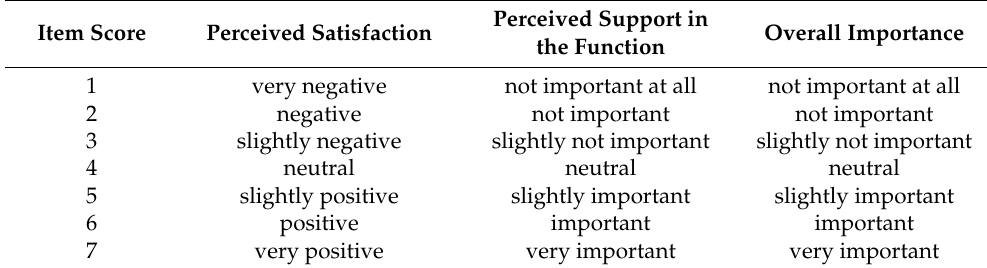
Table 6. Scoring table for the post-test questionnaire for the factors with their semantic meaning and the corresponding value of 1–7 in the Likert scale